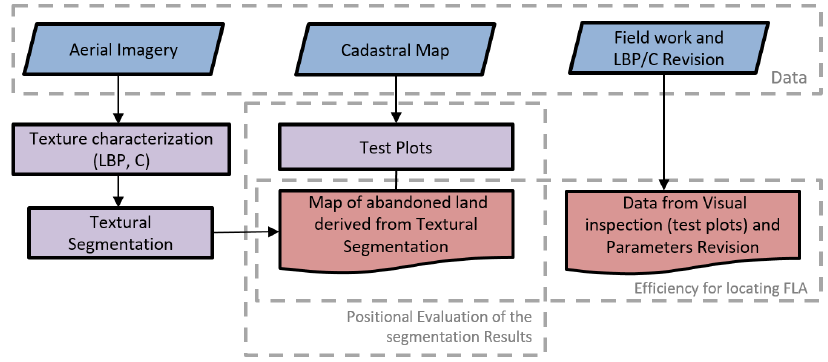
Figure 2. Workflow of the proposed methodology.